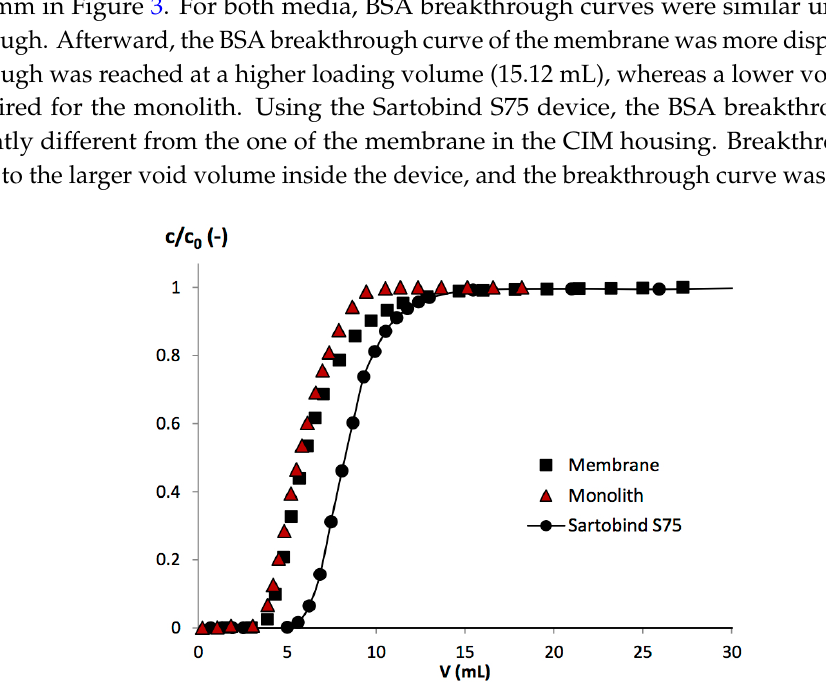
Figure 3. Comparison between experimental non-binding breakthrough curves of BSA obtained with the membrane ( H = 3 mm), monolith ( H = 3 mm) in the CIM housing and the Sartobind S75 device. The experimental breakthrough curves were obtained using 100 mM phosphate buffer pH 6.0 at the BSA/LF initial concentration of 2/1 and a flow rate of 12.0 BV·min − 1 .